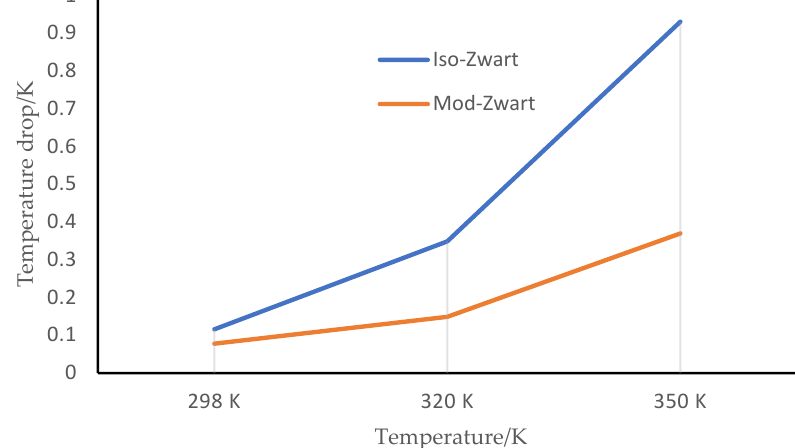
Figure 5. Temperature difference distribution of liquid water in different cavitation models at three different temperatures.